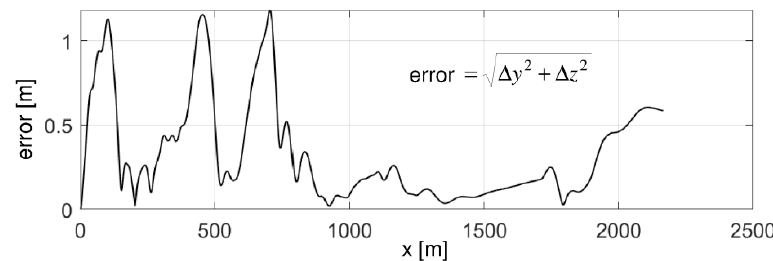
Figure 14. The control errors between the performed and set flight trajectory.